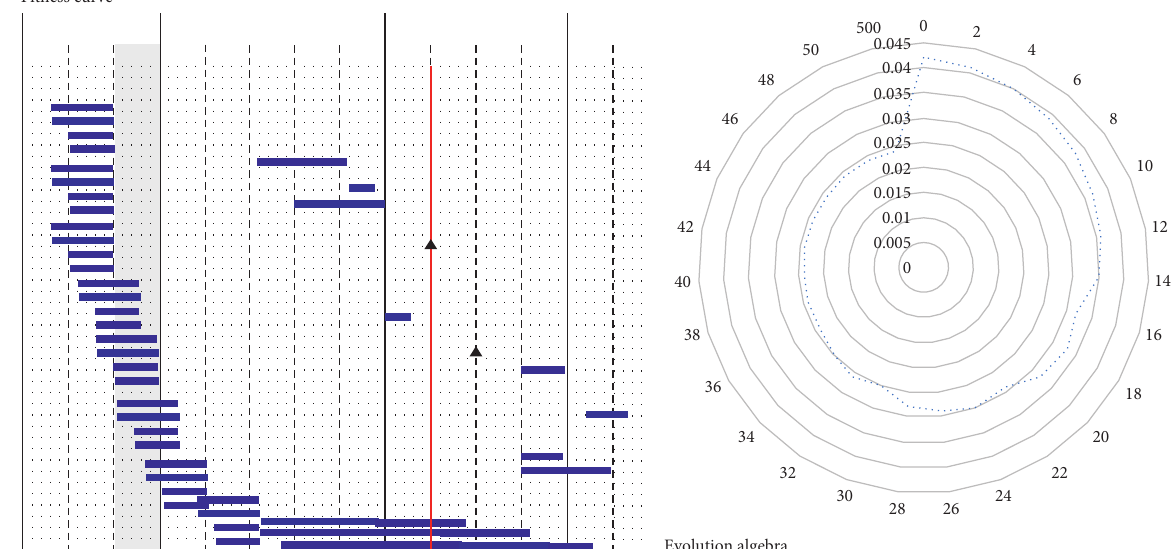
Figure 8: The cuckoo search algorithm converges on stability evaluation of rock